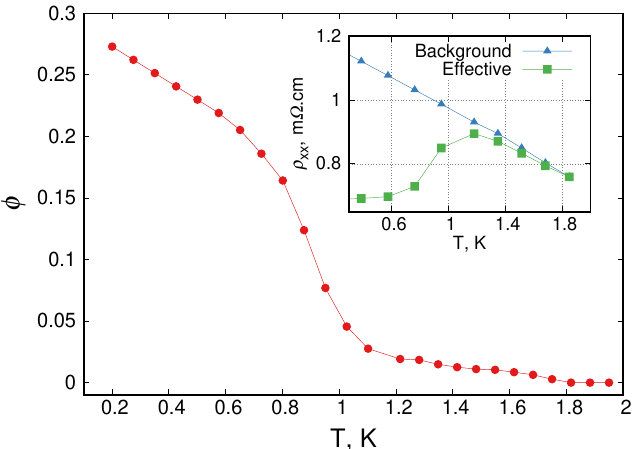
Figure 2. Dependence of SC volume ratio φ on temperature. φ (red,circle) is calculated using Equation (10) for i = x and the experimental data on resistivity along the x -axis, taken from Figure 2c of Ref. [6] and shown in the inset. (inset) The effective medium resistivity ρ xx containing SC, metallic and SDW phases (green squares), and the background resistivity ρ b xx in the absence of SC islands (blue triangles), taken from the data in Figure 2c of Ref. [6] in magnetic field.